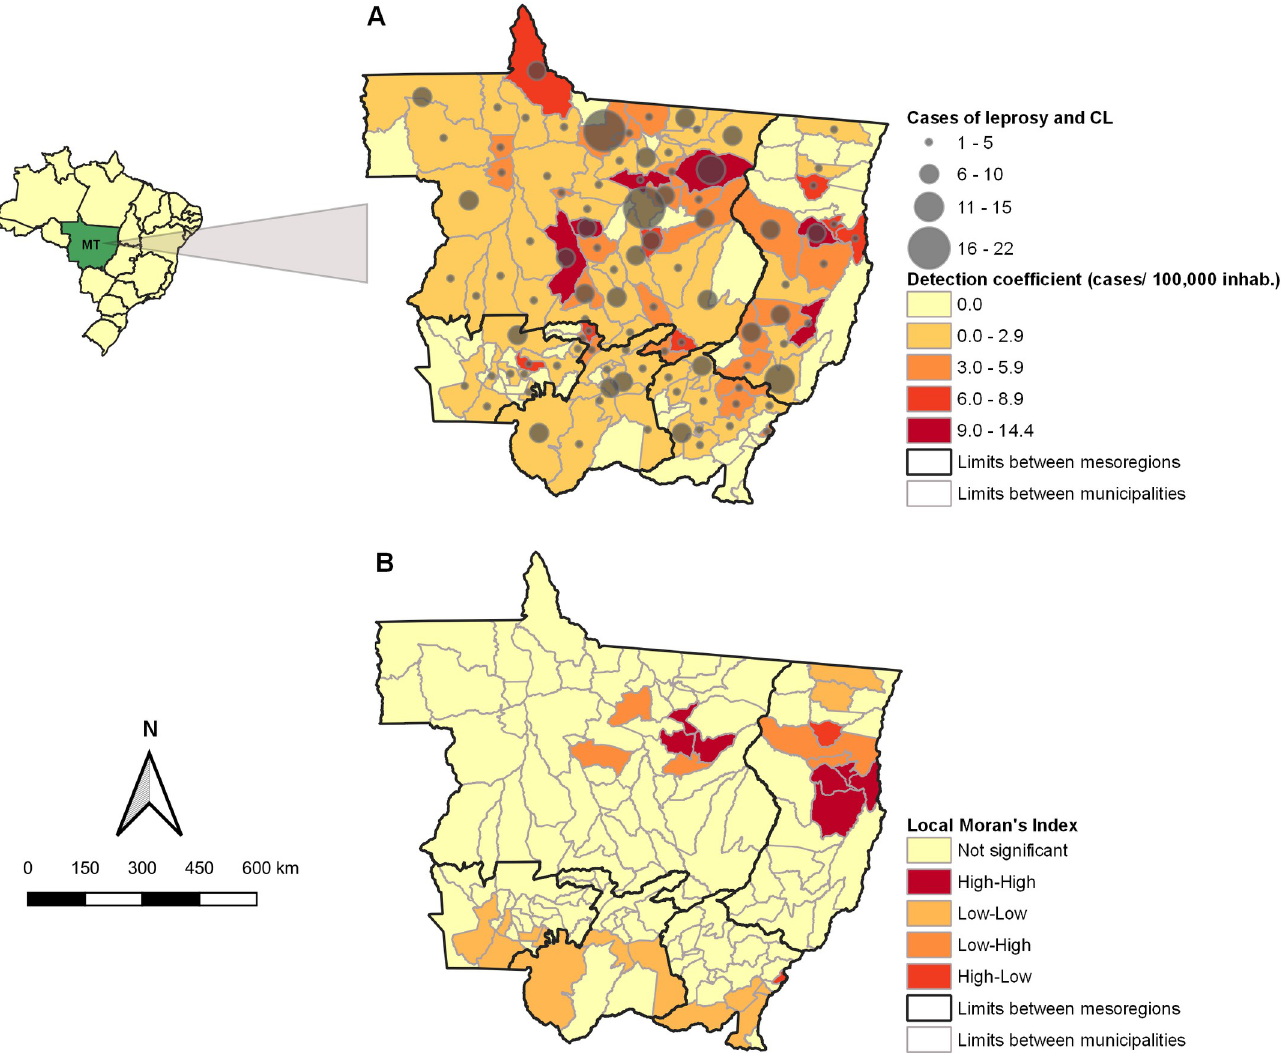
Fig 2. Geographic characterization of the patients diagnosed with leprosy and cutaneous leishmaniasis (CL) in Mato Grosso state, Brazil, 2008–2017. (A) Represents the absolute number of patients and the cumulative detection coefficient for leprosy and CL in the same individuals per municipality. (B) Represents the local Moran’s Index analysis for the cumulative detection coefficient per municipality. The digital georeferenced database of the municipalities was obtained from the Brazilian Institute of Geography and Statistics (https://geoftp.ibge.gov.br/organizacao_do_territorio/malhas_territoriais/malhas_municipais/municipio_